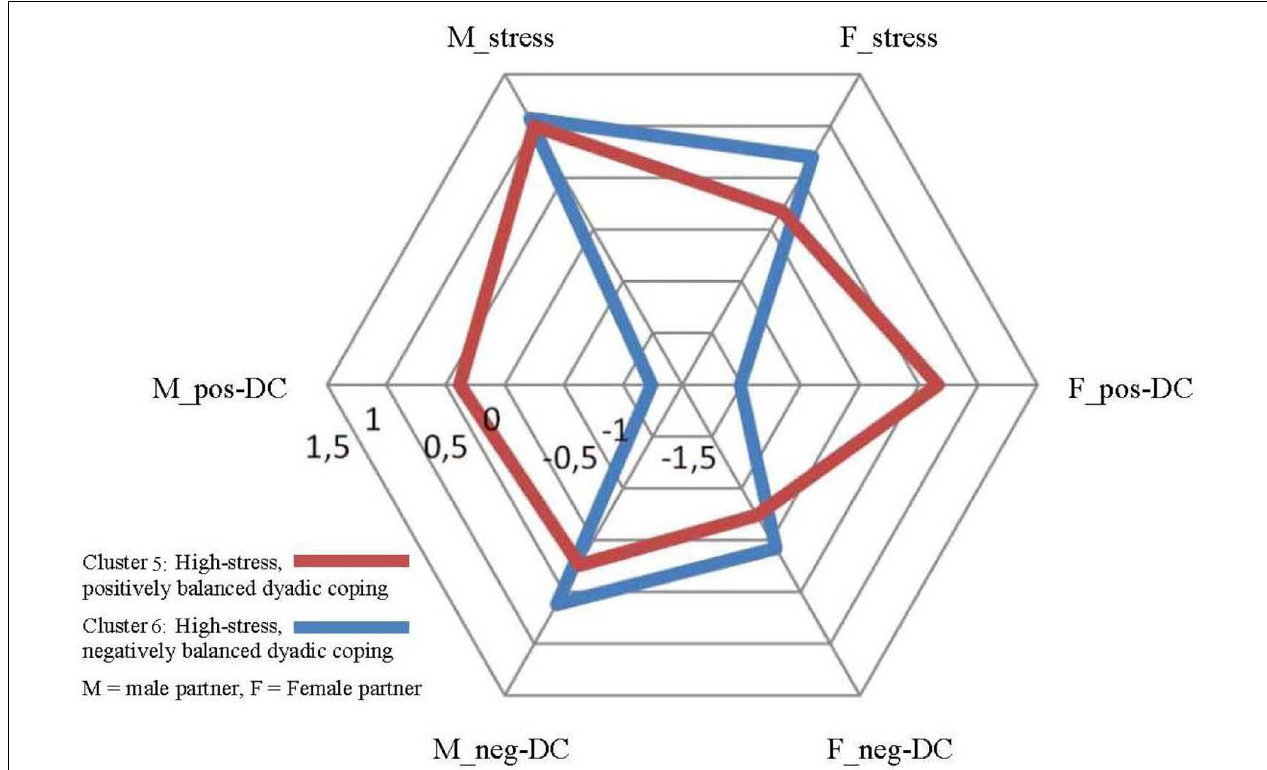
FIGURE 3 | High-stress couples: Cluster centers of Cluster 5 and 6,